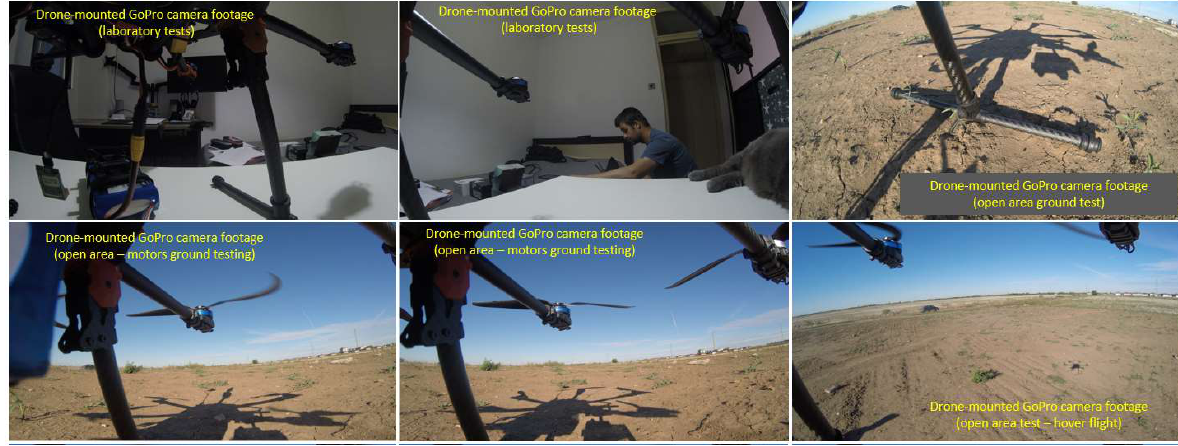
Figure 21. Drone-mounted GoPro camera footage, on the ground and in flight.